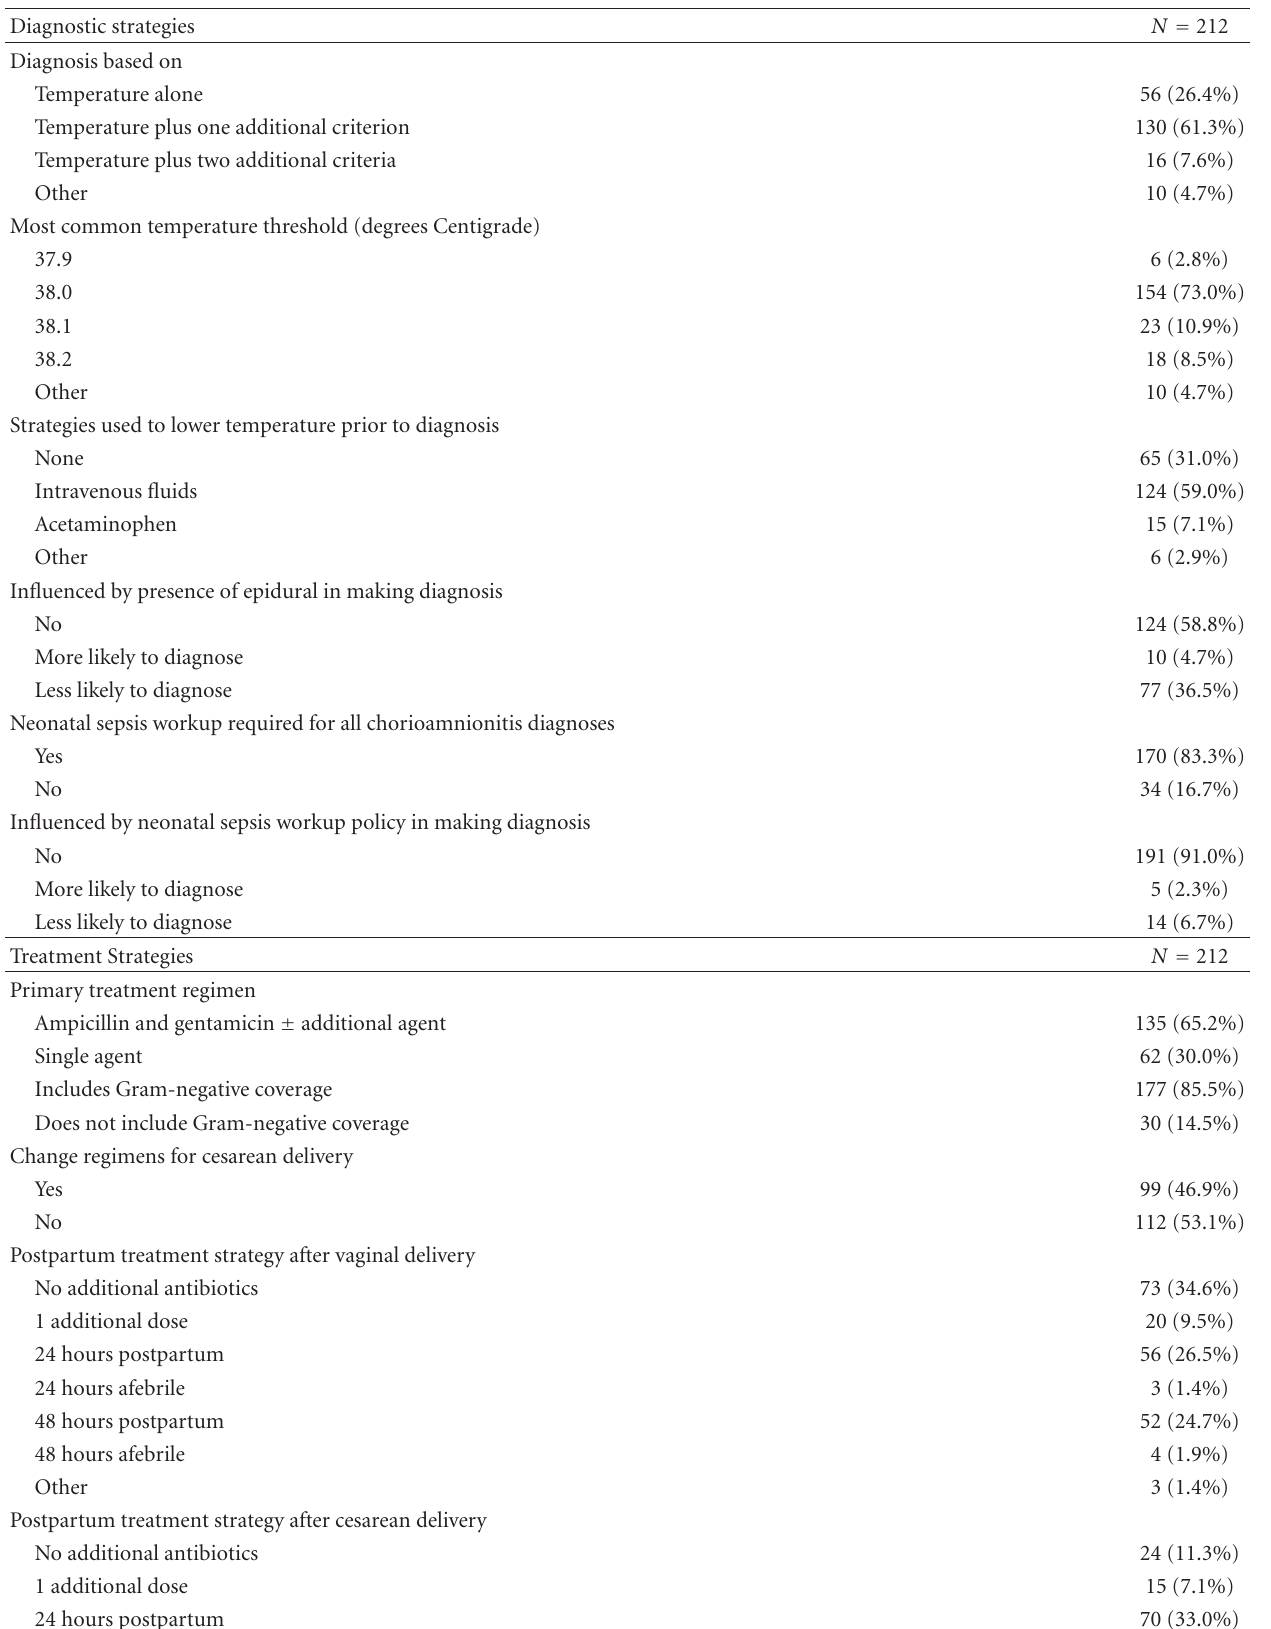
Table 3: Diagnostic and treatment